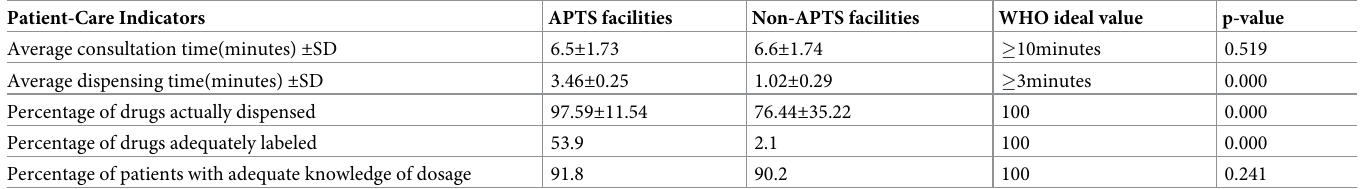
Fig 6. Percentage of drug actually dispensed drugs, drugs adequately labeled and patients with adequate knowledge by each facility of APTS and non-APTS. N: Non-APTS facilities, A: APTS facilities. https://doi.org/10.1371/journal.pone.0223523.g006 Table 3. Comparison of WHO patient care indicators (consultation time, dispensing time, labeled medicines and actually dispensed) between encounters of APTS primary hospitals and Non-APTS primary